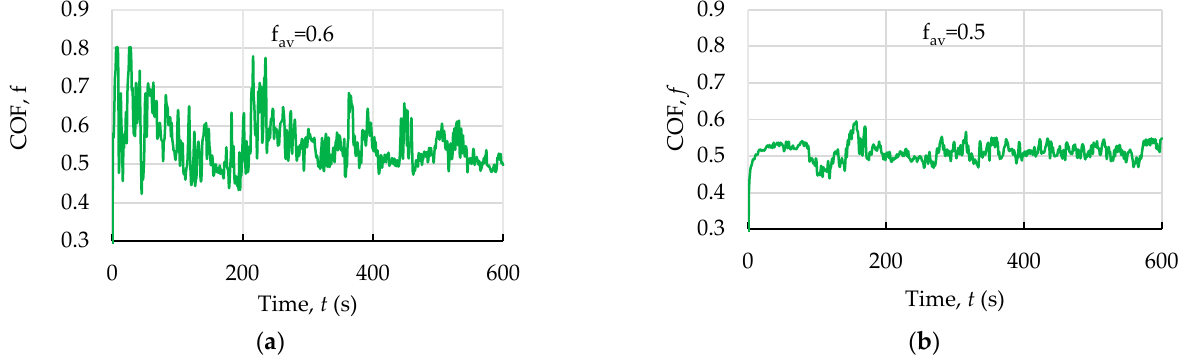
Figure 8. Friction factor diagrams of the studied BT22 alloy: ( a ) as manufactured, no treatment; ( b ) after nitriding.